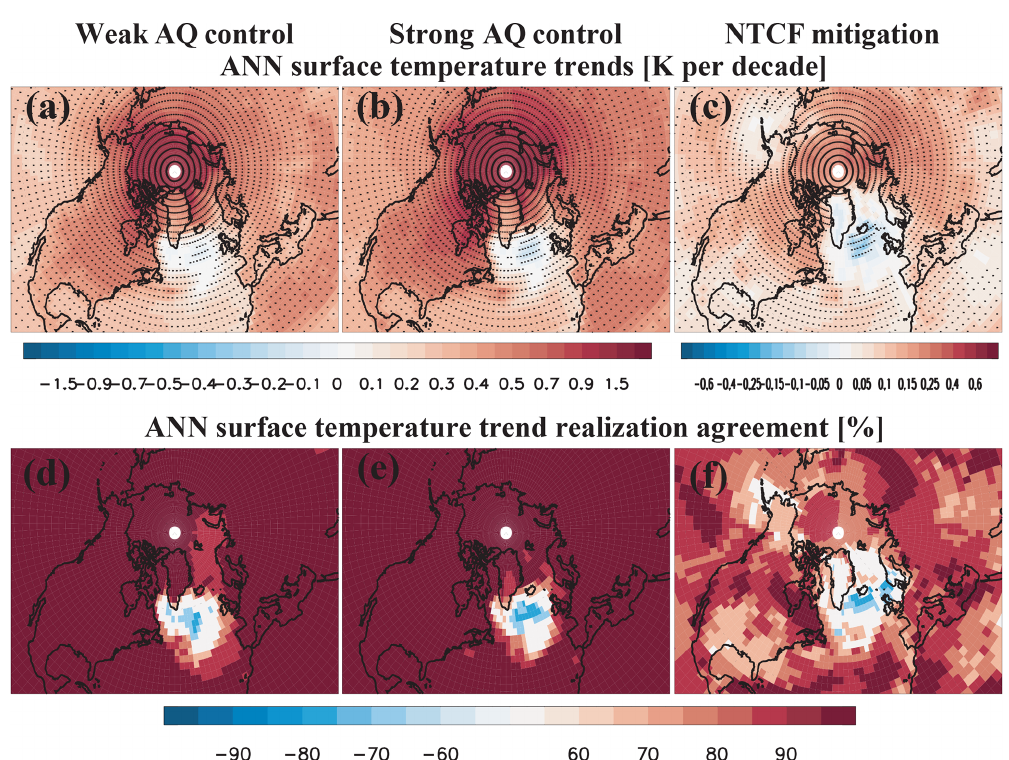
Figure 6. The 2015–2055 annual mean surface temperature trends and model trend realization agreement over the Arctic. Surface tempera- ture (a–c) trends (Kdecade − 1 ) and (d–f) model trend realization agreement (%) for (a, d) weak air quality control, (b, e) strong air quality control, and (c, f) NTCF mitigation. Stippling denotes trend significance at the 95% confidence level based on a standard t test. Trend real- ization agreement represents the percentage of models that agree on the sign of the trend. Red colors indicate model agreement on a positive trend; blue colors indicate model agreement on a negative trend. White areas indicate lack of agreement on the sign of the